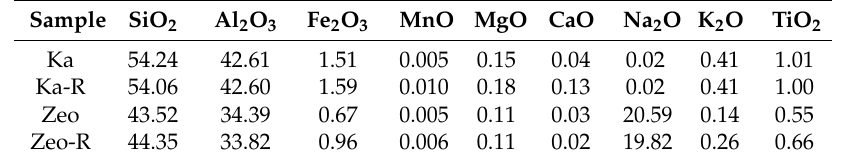
Table 3. Chemical composition (wt %) of the parent purified kaolins (Ka and Ka-R) and of the obtained